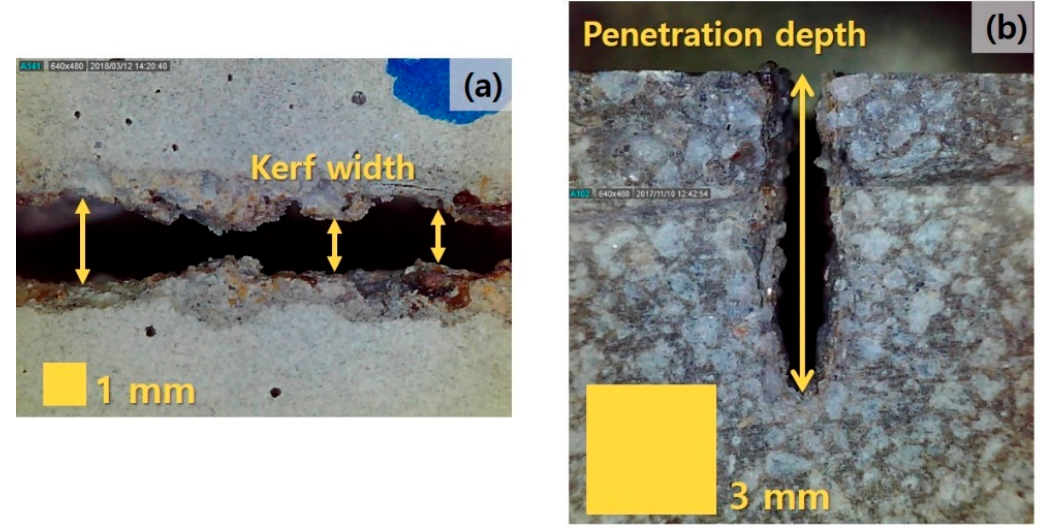
Figure 2. Examples of evaluation of ( a ) kerf width and ( b ) penetration depth.